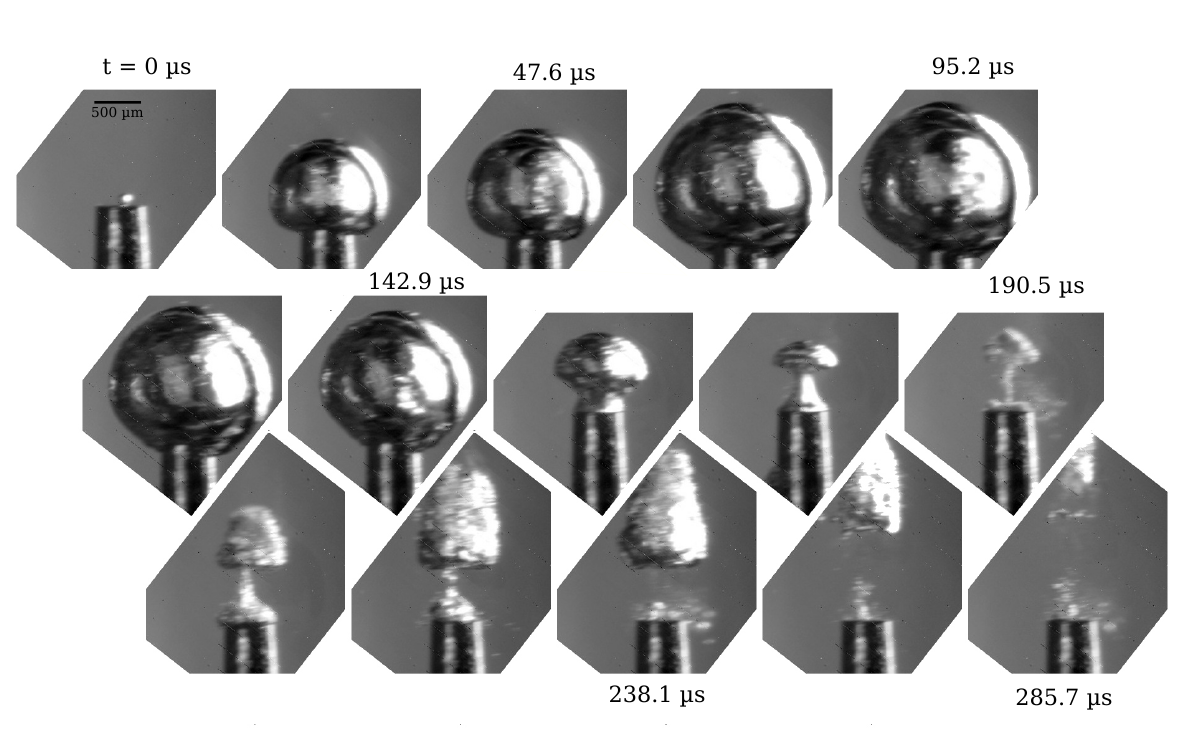
Figure 4. Image sequence of a typical mushroom bubble generated in the center of the top surface of a metal cylinder at D ∗ ≈ 0. Radius of the cylinder top is r p = 272.8µm. Exposure time is 1 µs. Stacked and interleaved sequences of four recordings with the Photron camera at 21kfps each. The times for one of the sequences are given. The frames without a time tag are taken from different measurements as an interpolation. The bubble has a maximum horizontal width of 1689µm ± 18µm at 95.2